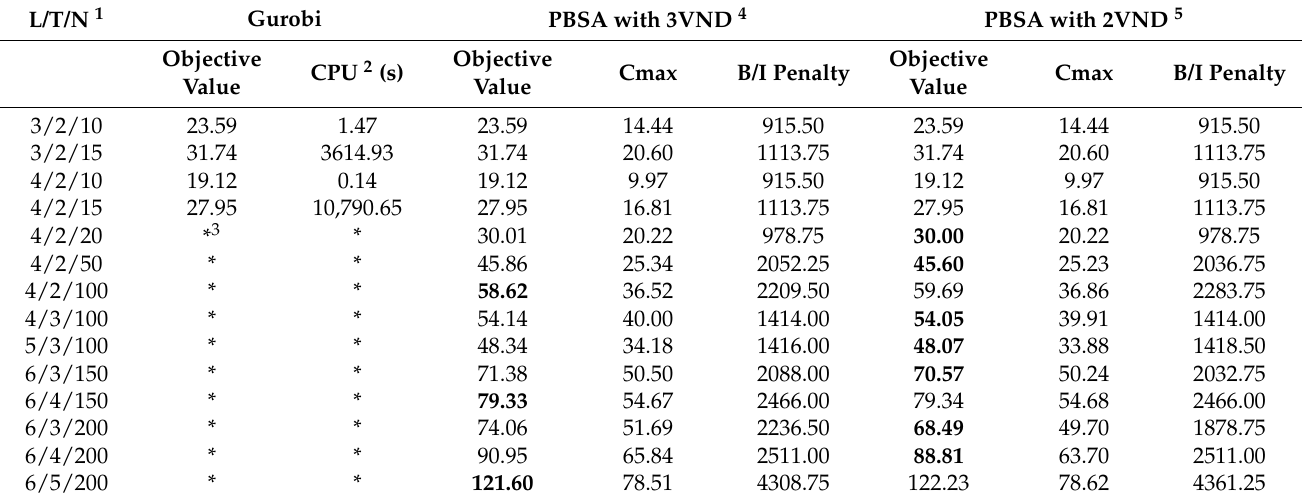
Table 3. Validation of the proposed PBSA algorithm.